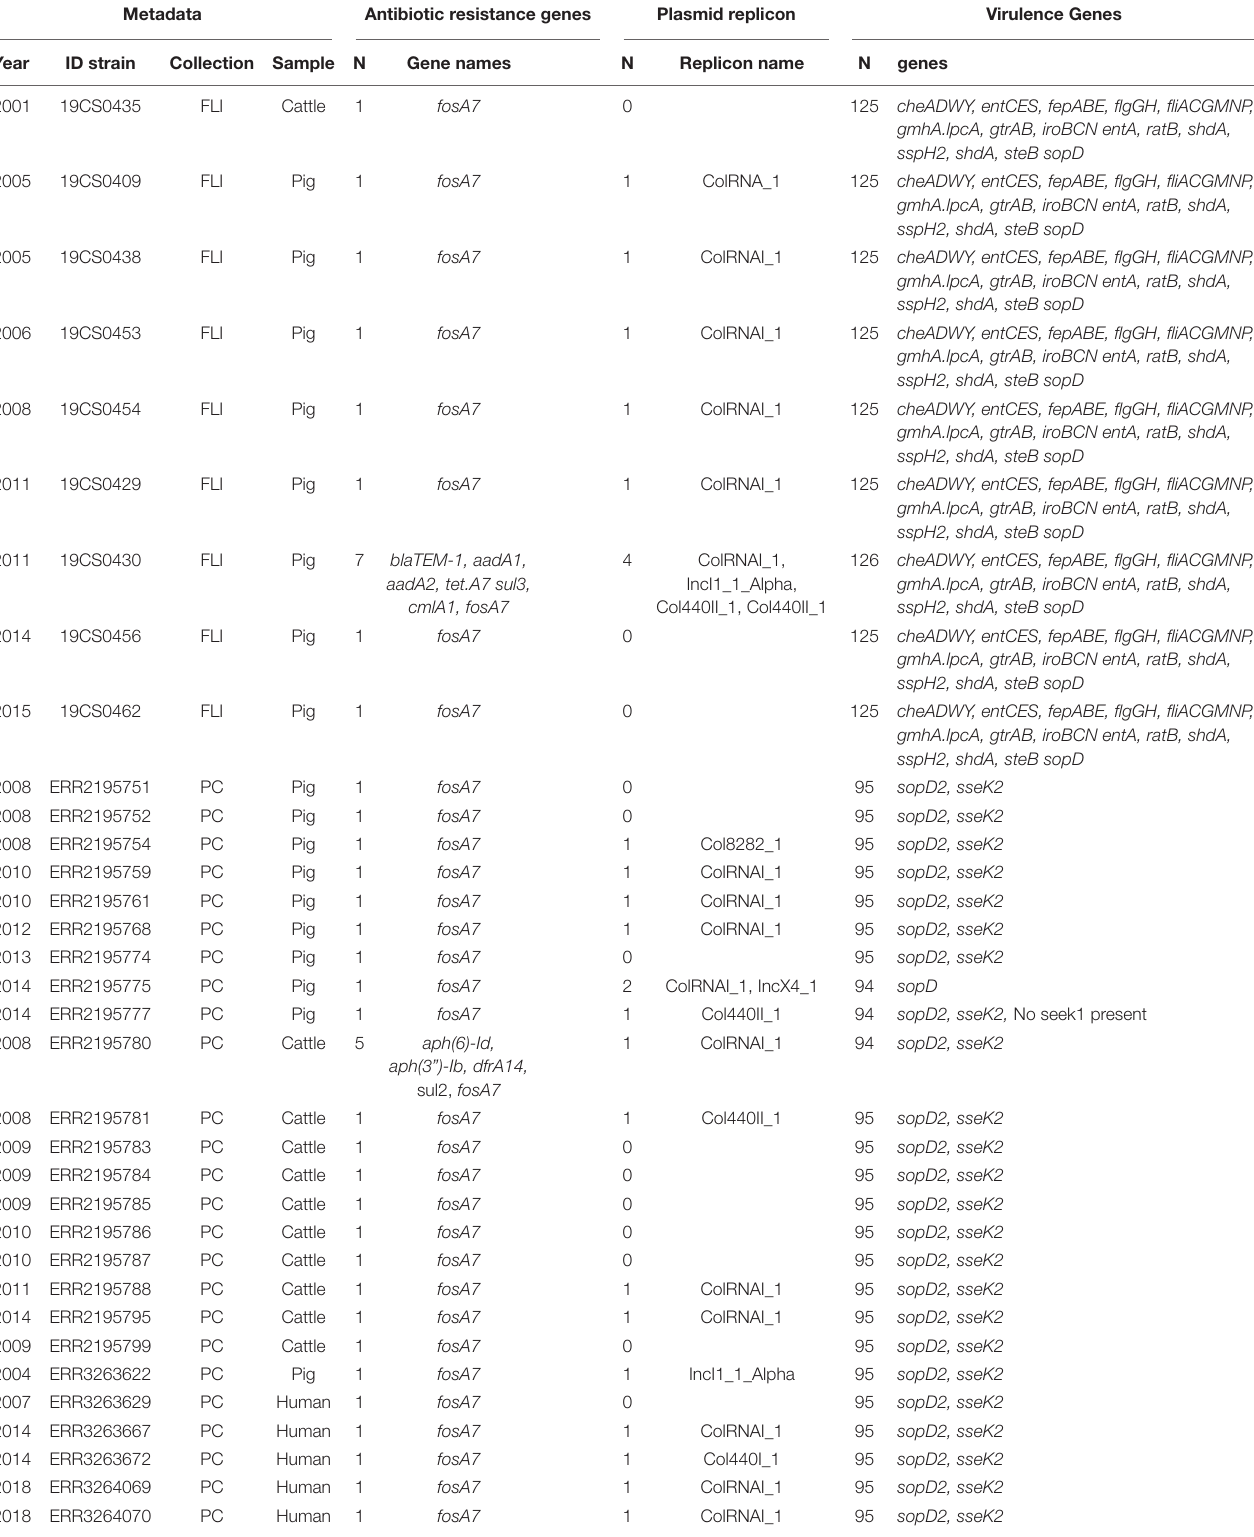
TABLE 2 | ST39 genome information about the antimicrobial resistance genes, plasmid replicons and virulence genes, n = 34.